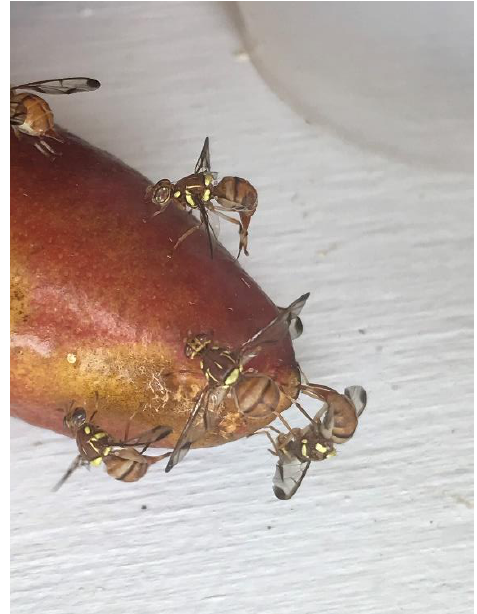
Figure 2. Melon flies ( Zeugodacus cucurbitae ) ovipositing on a finger lime in the no-choice cage test with a low fruit fly